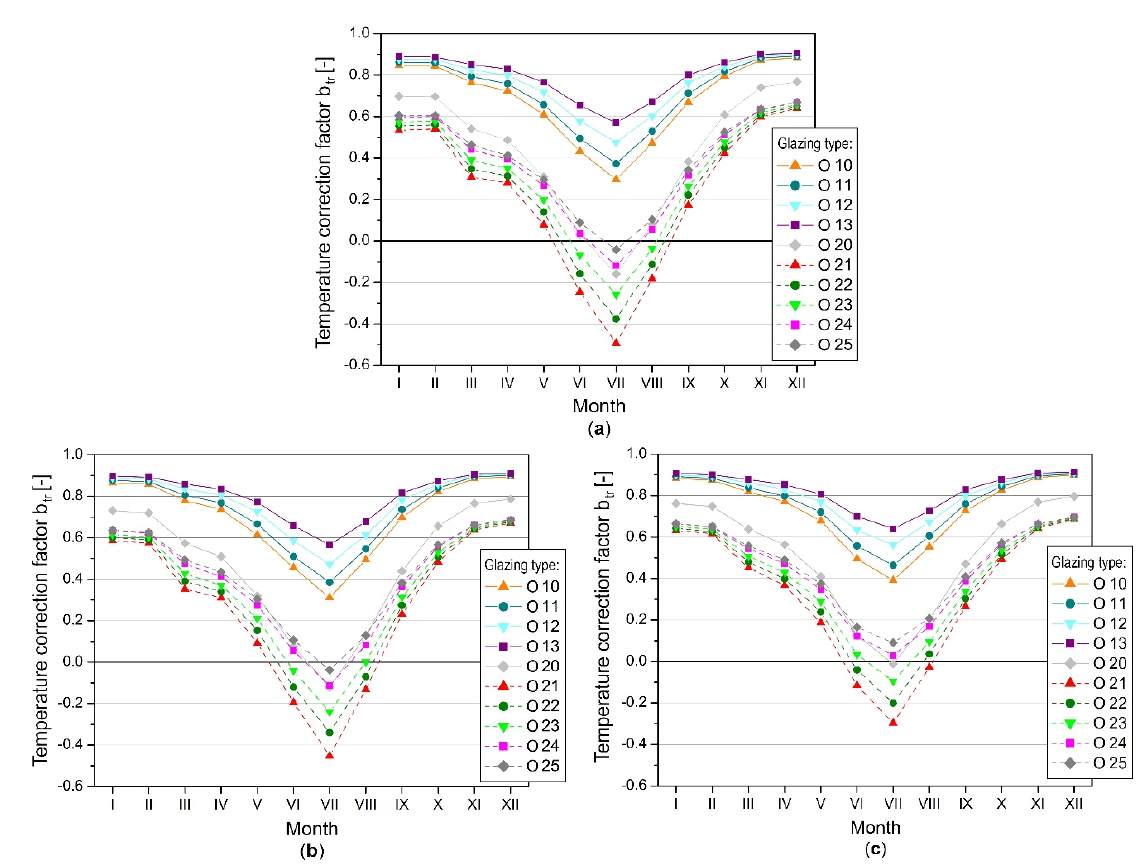
Figure 8. Temperature correction factor, glazing height 2.20 m: ( a ) balcony facing south; ( b ) balcony facing east; ( c ) balcony facing west.